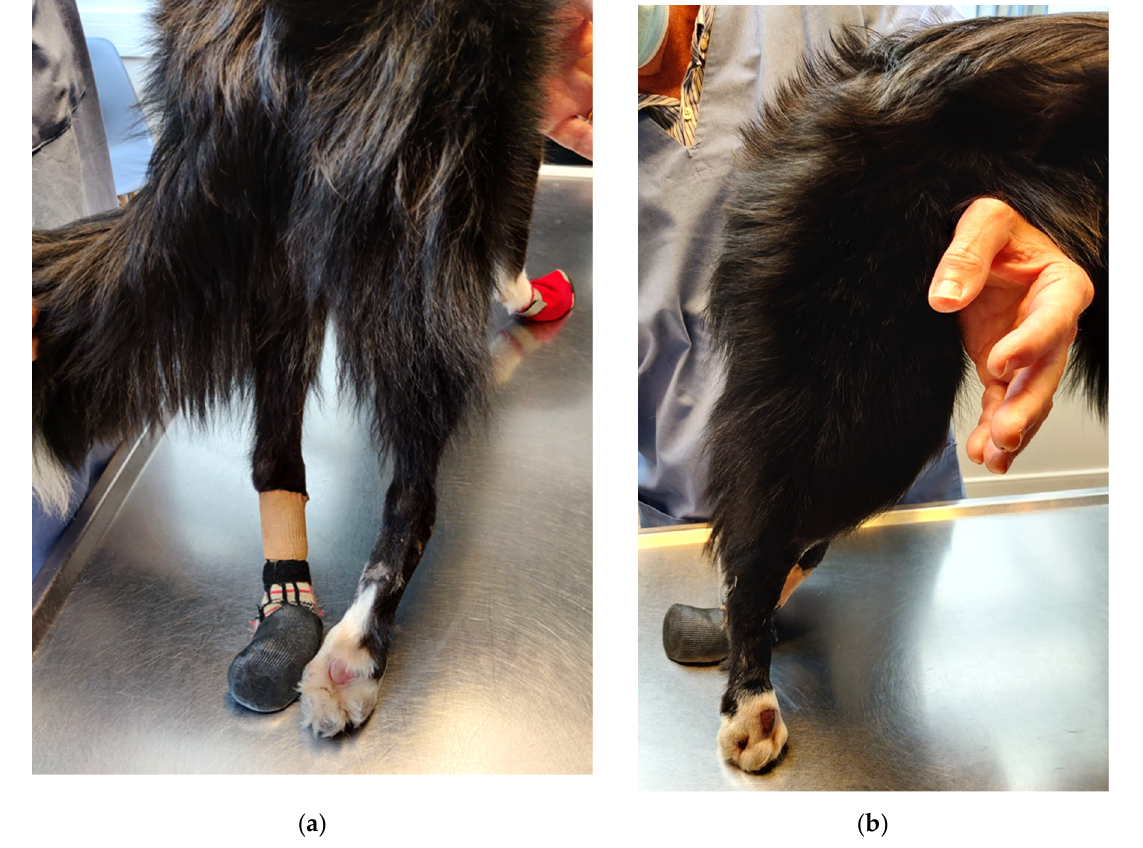
Figure 2. ( a ) Severe proprioceptive deficits with spontaneous knuckling and hyperextension of the tarsal joint. ( b ) Absence of self-mutilation with improvement of the digit lesions with oclacitinib administration.